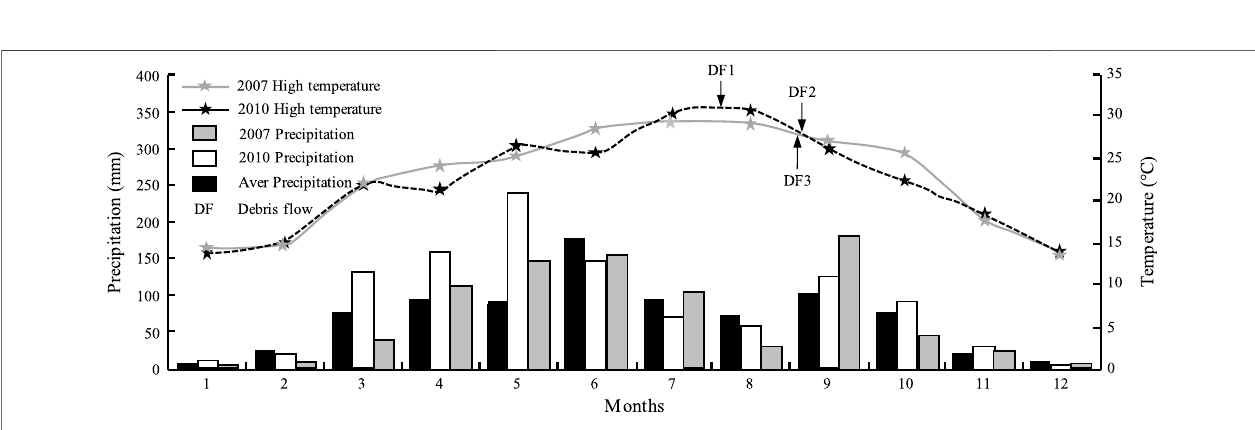
FIGURE 2 | Monthly precipitation and temperature data of Tianmo gully in 2007 and 2010. Data sourced from Ge et al. (2014).